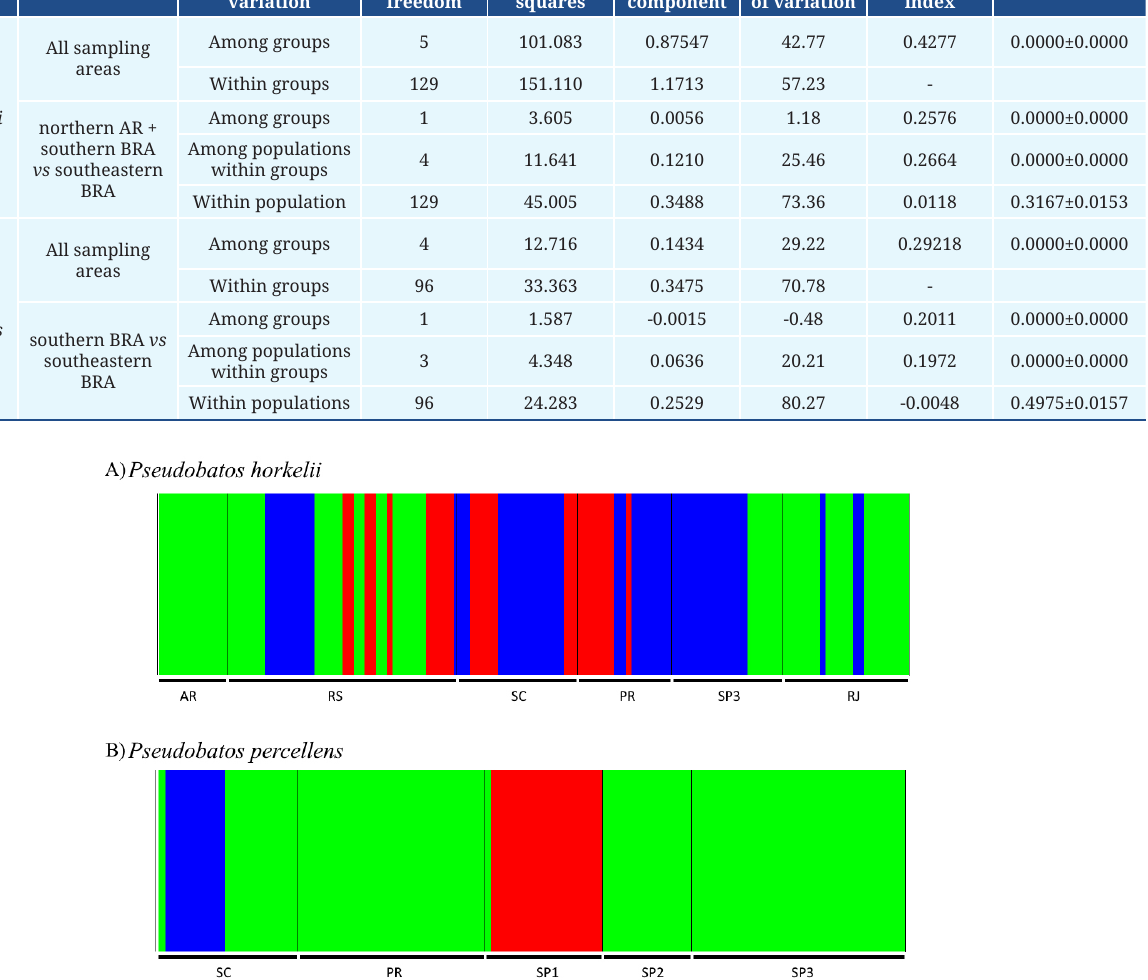
TABLE 3 | Hierarchical AMOVA for the control region of Pseudobatos horkelii and P. percellens . Samples of P. horkelii were grouped into northern Argentina (AR), southern Brazil (BRA: RS, SC, PR) and southeastern Brazil (BRA: SP3, RJ). Whereas for P. percellens , were grouped into southern Brazil (BRA: SC, PR) and southeastern Brazil (BRA: SP1, SP2, SP3). Source of Degrees of Sum of Species variation freedom